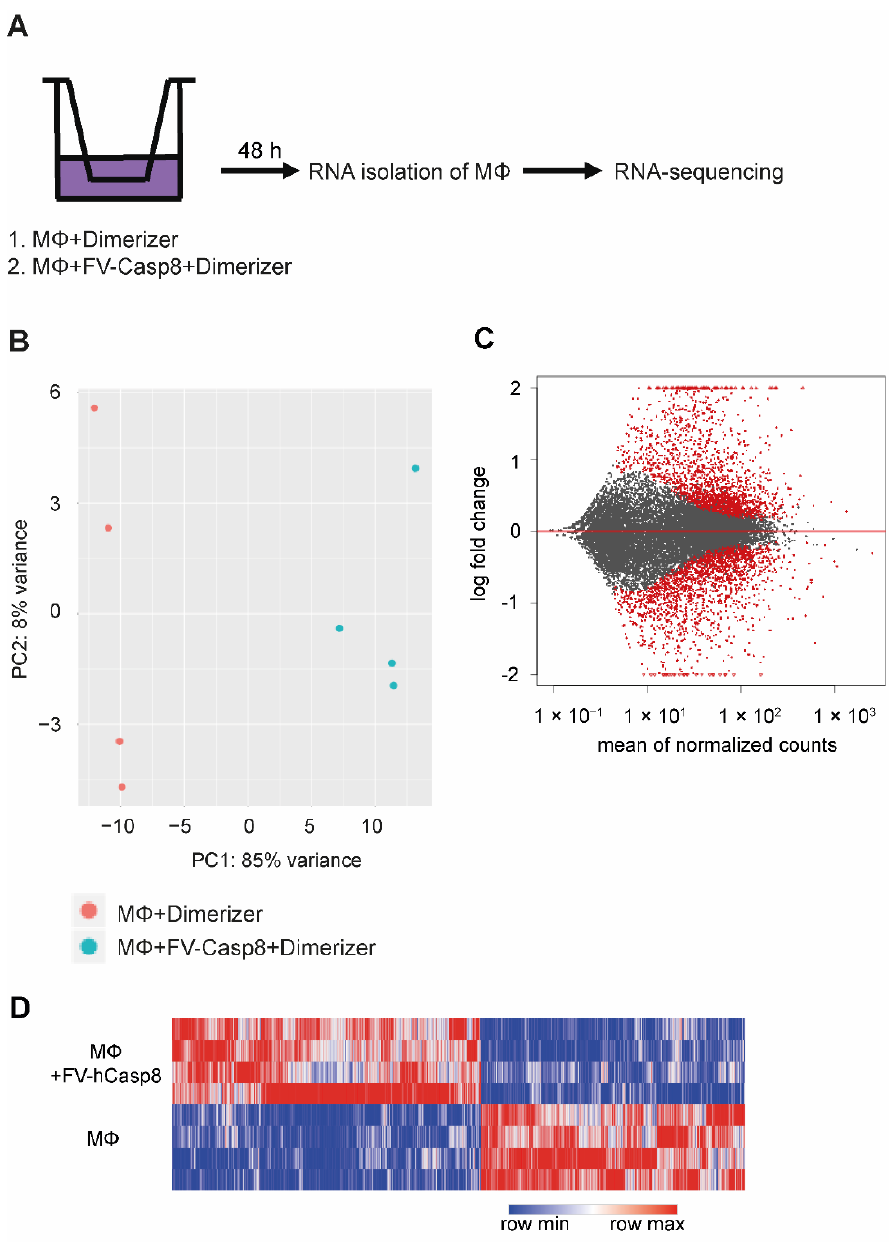
Figure 3. mRNA-sequencing of macrophages co-cultured with apoptotic cells. ( A ) Depiction of the experimental setup of RNA sequencing: Peritoneal macrophages (M Φ ) were co-cultured with or without NIH 3T3 cells expressing FV-hCasp8 and incubated with dimerizer for 48 h in a transwell system. mRNA of macrophages was isolated and RNA sequencing was performed. ( B ) Principal component analysis (PCA) plot shows the variance of sample groups regarding their gene expression. ( C ) MA plot depicting the fold change of all genes against the mean of normalized counts of all samples is shown (grey dots). Red dots represent genes with a p -value smaller than 0.001, red triangles represent genes with log2 fold < − 2 or >2. ( D ) Hierarchical clustering and heat map of differentially expressed genes are shown. 2905 genes were differentially expressed with a base mean higher than 30 and a p value lower than 0.05 ( n =